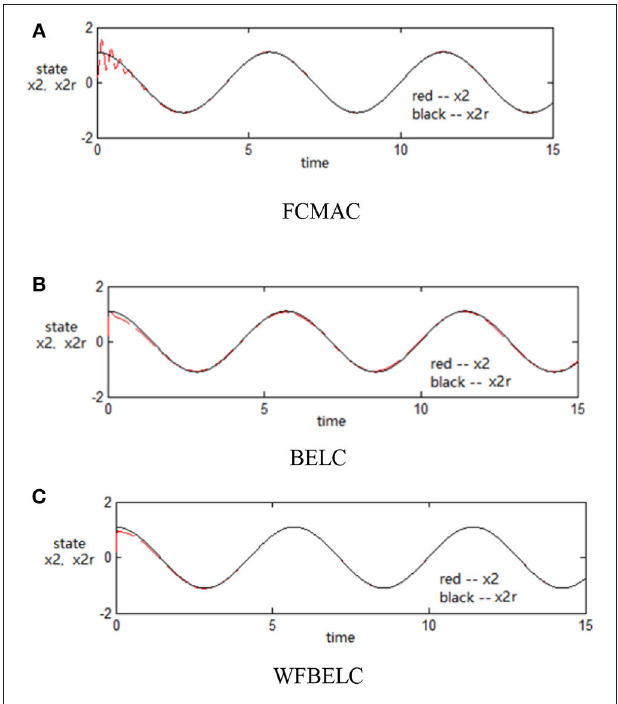
FIGURE 12 | Change trend chart of the control signal u ( q = 8) (A) FCMAC, (B) BELC, and (C)